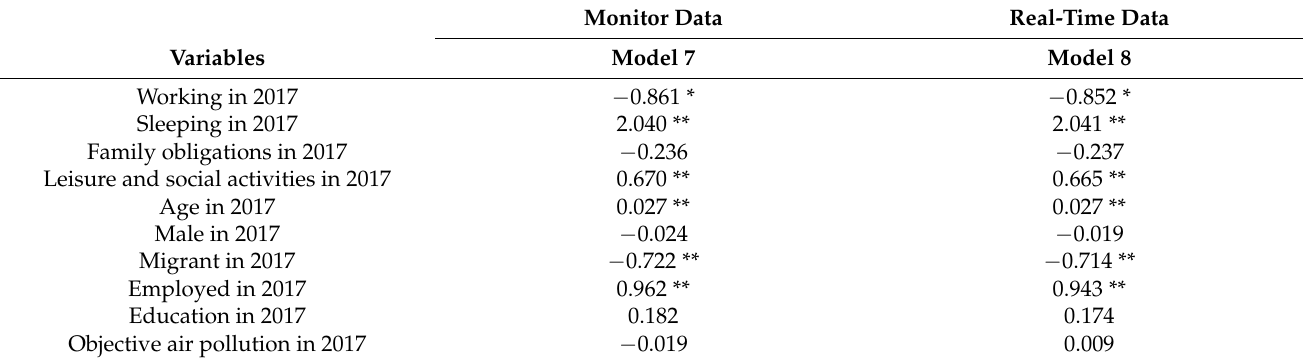
Table 4. Estimated coefficients of logistics models for